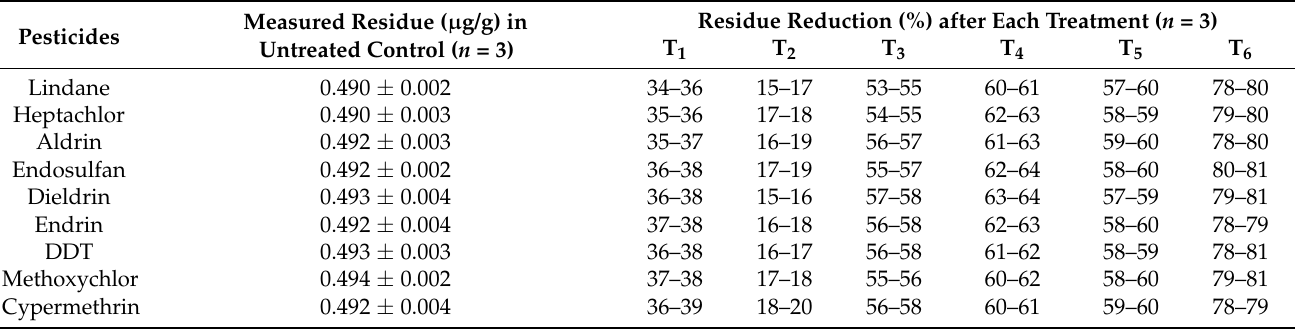
Table 6. Reduction in pesticide residues (%) from three-spot gourami (Trichogaster trichopterus) by the six household